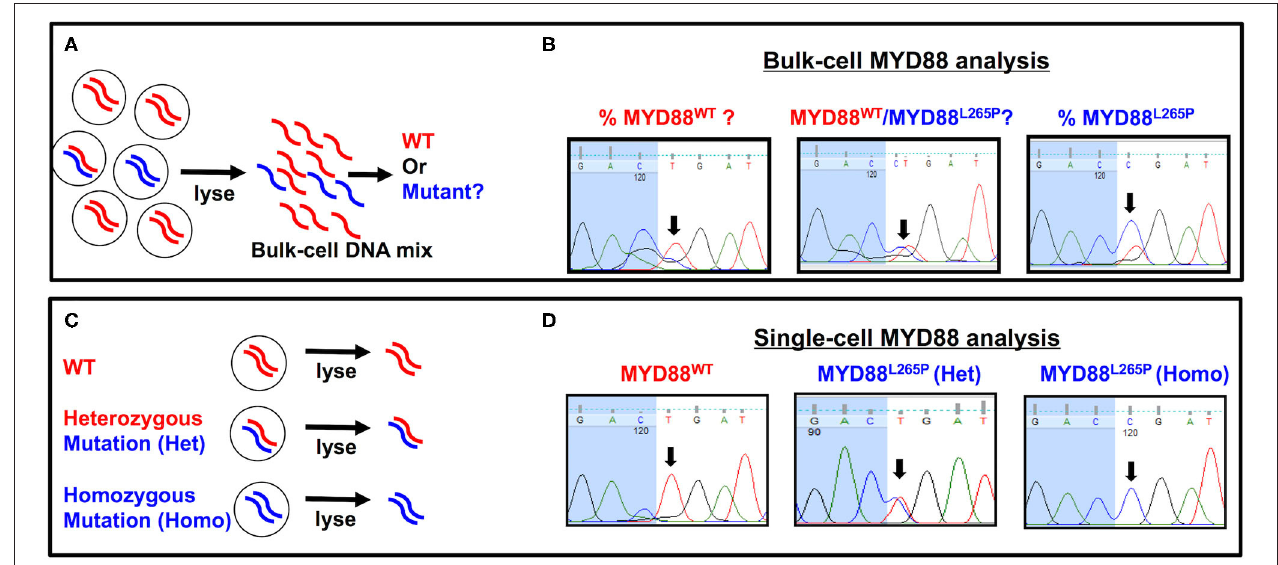
FIGURE 1 | Comparison of bulk cell-vs. single cell-based MYD88 analysis. (A) A heterogeneous cellular sample with MYD88 WT (red) or MYD88 L265P mutants (blue) was lysed for bulk-cell myeloid differentiation primary response 88 (MYD88) analysis. (B) An electropherogram showing sequencing peaks for MYD88 WT and MYD88 L265P . The black arrows throughout indicate the location of a T → C point mutation corresponding to MYD88 WT (C T G) or MYD88 L265P (C C G), respectively. (C) Individual cells with MYD88 WT (red/red), heterozygous (red/blue), or homozygous MYD88 L265P mutant (blue/blue) were isolated and lysed for single cell-based MYD88 analysis. (D) An electropherogram showing clean and well-resolved sequencing peaks for MYD88 WT , heterozygous (red/blue), or homozygous MYD88 L265P alleles from the single cells. The black arrows throughout indicate the location of a T → C point mutation corresponding to MYD88 WT (C T G) or MYD88 L265P (C C G), respectively. WT, wild-type MYD88 WT ; mutant, MYD88 L265P